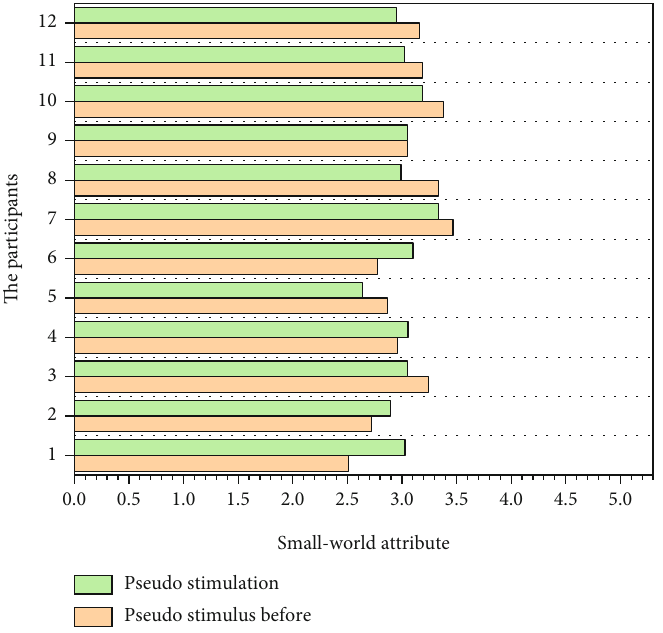
Figure 1: Network small-world attributes before and after